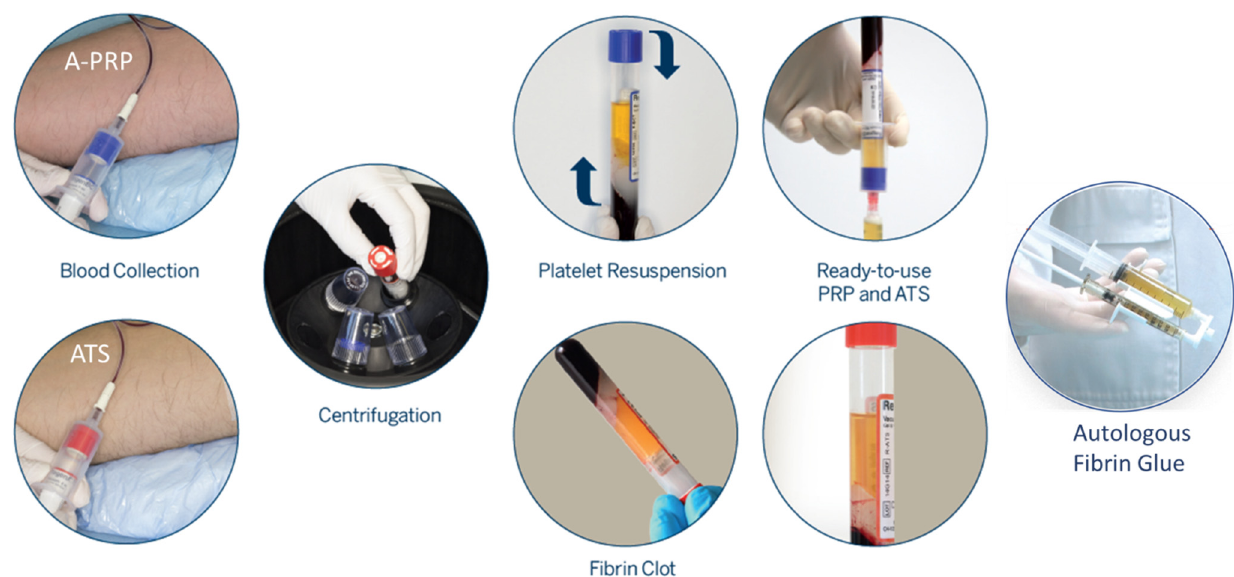
Figure 2. Preparation of autologous fibrin glue using Regenkit-Surgery, RegenLab Switzerland. The kit allows the close circuit preparation of A-PRP and ATS using a separating gel technology. The kit contains two tubes with sodium citrate anticoagulant (blue cap) for PRP preparations and one tube without anticoagulant (red cap) for autologous thrombin preparation (ATS). The venous puncture is performed, and the three tubes are filled with whole blood. The vacuum within the tubes enables automatic collection of the necessary volume of blood (about 10 mL). Tubes are centrifuged to allow blood component separation. After centrifugation, the blood is fractionated; the red and white blood cells are trapped under the separating gel, and platelets settle on the surface of the gel. The tube is gently rocked to resuspend the platelets and about 5 mL of PRP will be obtained for each tube.During centrifugation of RegenATS tube, a clot of fibrin settles on the separating gel. The liquid part that is extracted from the clot constitutes the activated thrombin serum which is used to trigger the coagulation of anticoagulated PRP. PRP from the two tubes is collected in a 10 mL syringe. Two mL of autologous thrombin serum are collected in a 3 mL syringe in which 1 mL calcium gluconate (10% injectable) is added. Then the 2 syringes are mounted on the RegenSpray applicator and